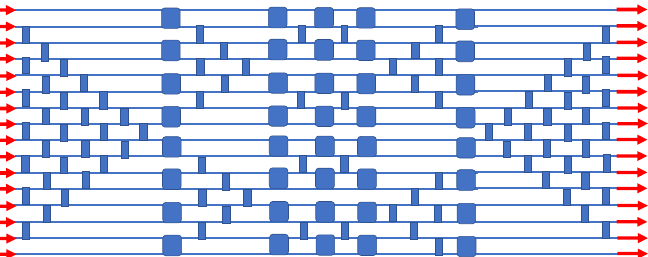
Figure 8. IDC block diagram of the monochromatic non-blocking 16 × 16 Clos–Benes spatial routing switch. This topology is based on the schematic in Figure 4 of [51].